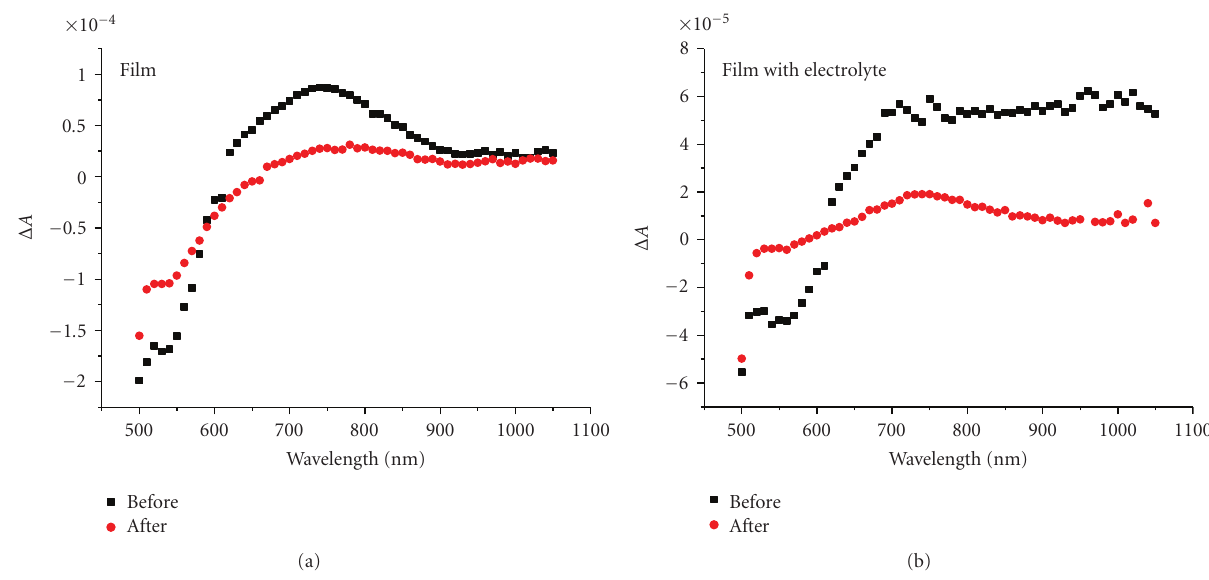
Figure 7: Photoinduced absorption spectra, excitation wavelength 450 nm with a frequency of 7Hz, E322 sensitized TiO 2 thin film in the absent (a) and the present (b) of redox electrolyte. For both cases, the measurements were carried out before and after employing the UV treatment.